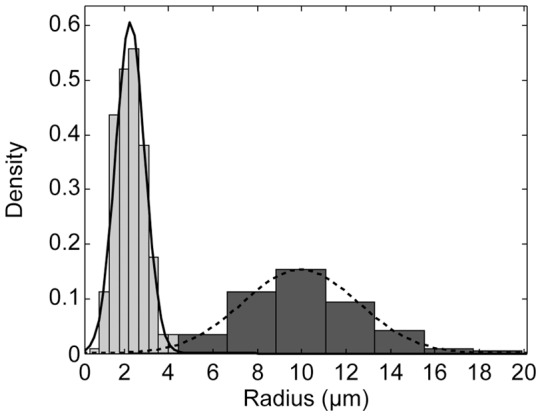
Size distribution of giant unilamellar vesicles (GUVs) and intact hierarchical unilamellar vesicles (HUVs).The size distribution of the GUVs is shown in light gray. The size distribution of the HUVs is shown in dark gray. Lines represent normal fits with mean 2.3 μm and standard deviation 0.7 μm (solid line) and mean 9.9 μm and standard deviation 2.6 μm (dashed line).